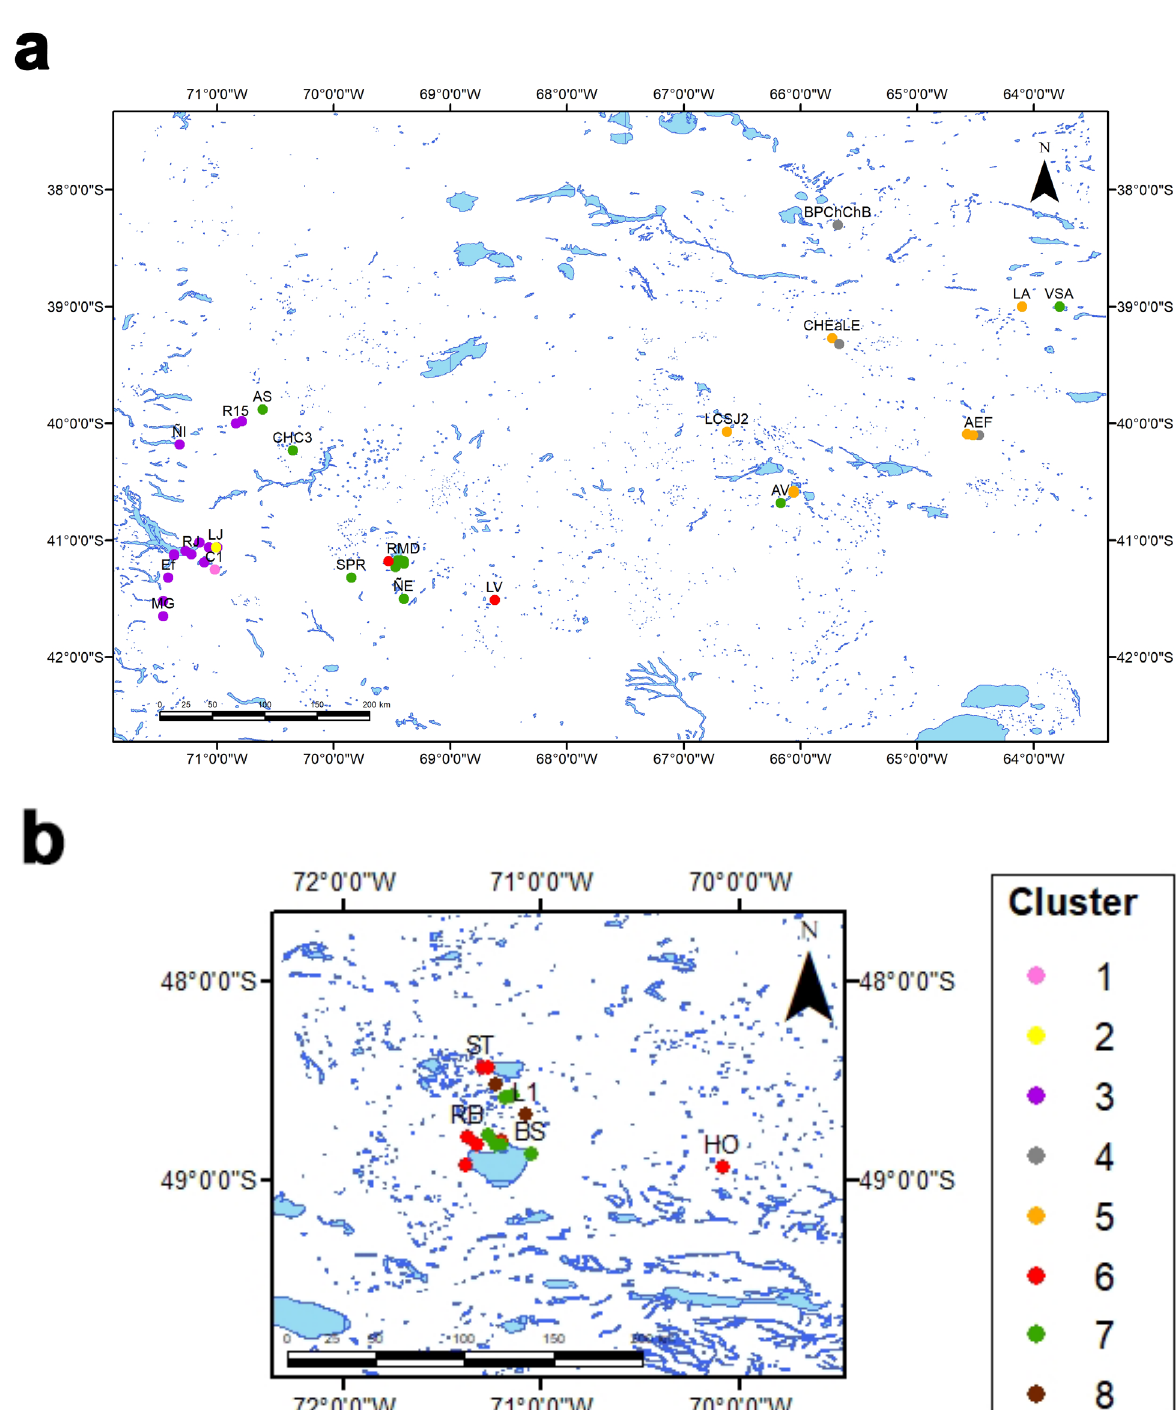
Figure 3. Map of sites grouped after cluster Analysis. a sites are located at 41 °S, in the study area A; whereas b sites are situated at 48 °S in the study area